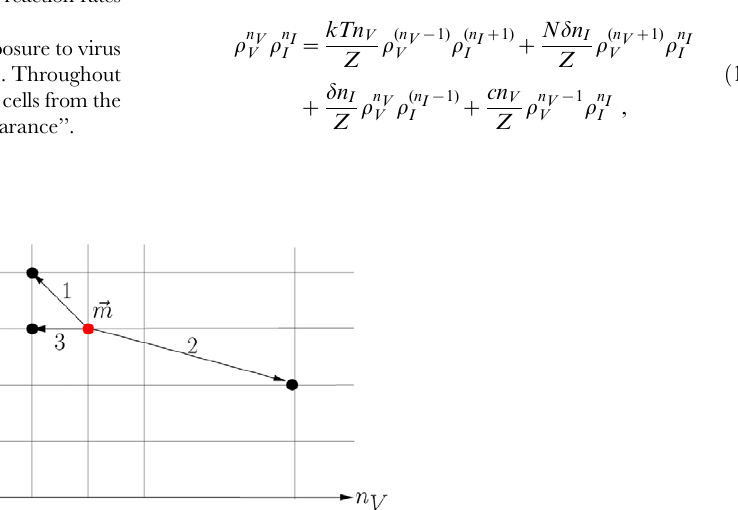
PLoS Computational Biology |